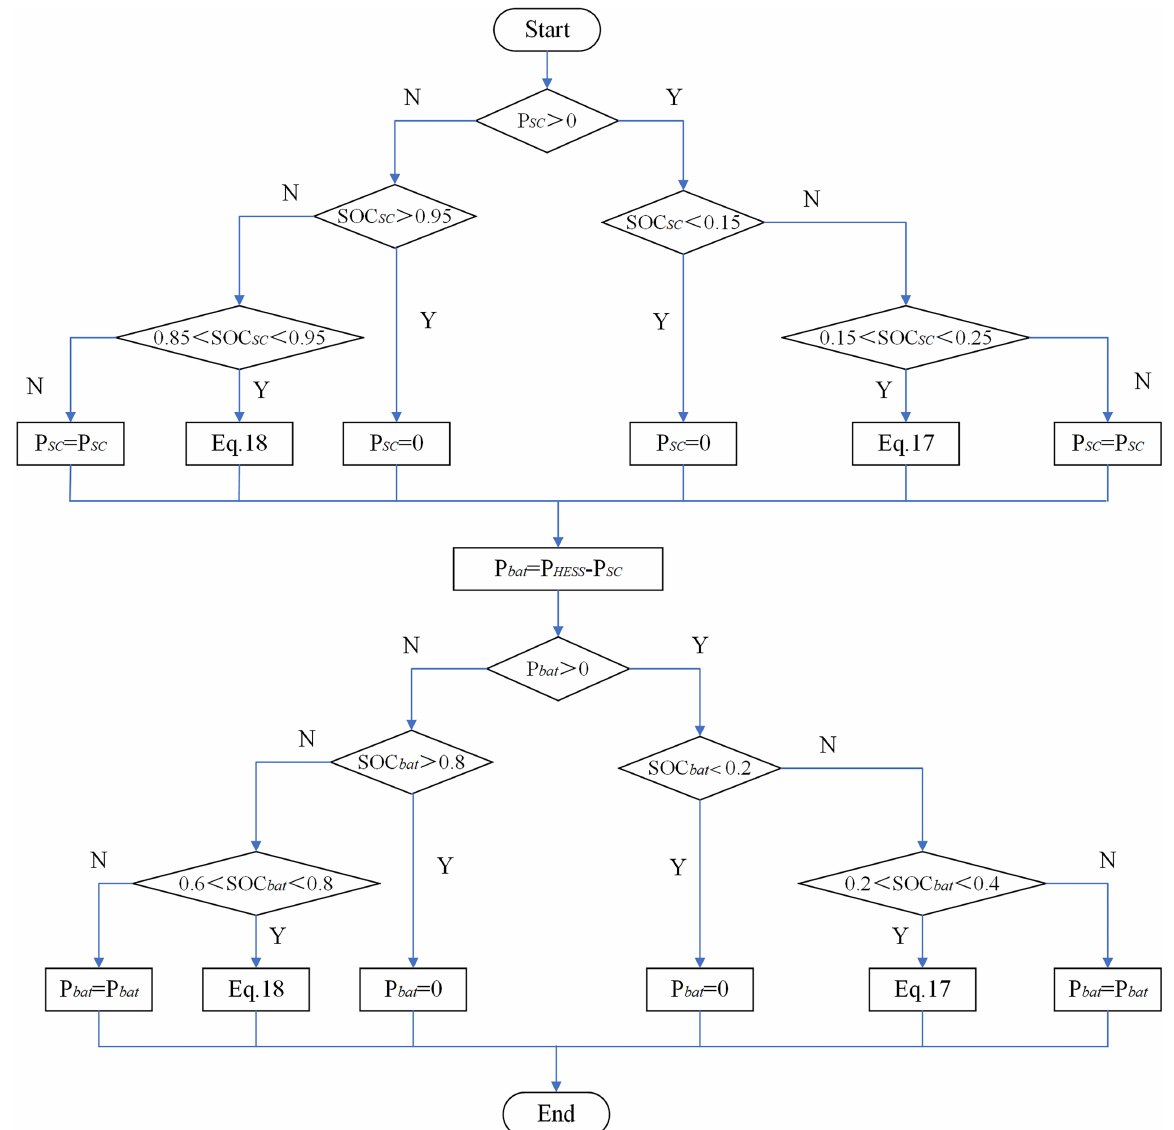
Figure 11. Flow chart of over-charge and discharge protection.